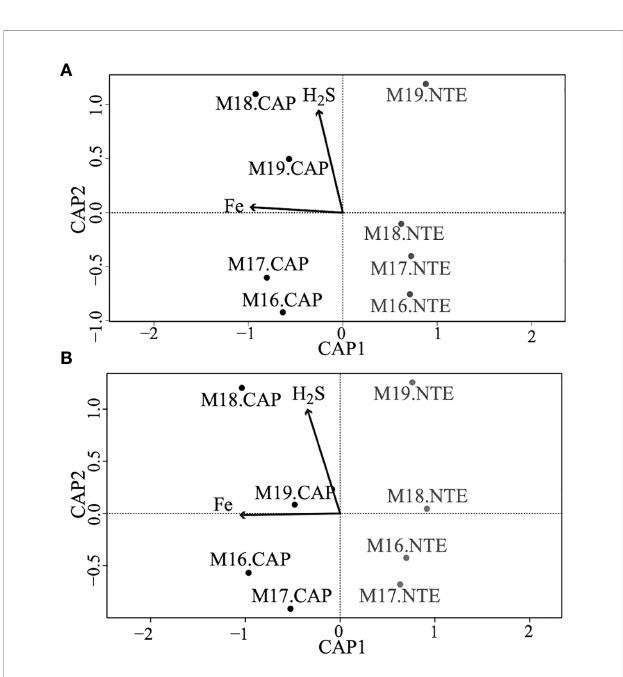
FIGURE 4 db-RDA plots representing the distribution of the samples from Capelinhos (black) and North Tour Eiffel (grey) sites depending on environmental parameters, (A) depicting bacterial communities, and (B) depicting archaeal communities. Samples from 2020 were not included in these plots as no hydrothermal fl uid samples could be collected on that year due to the Covid-19